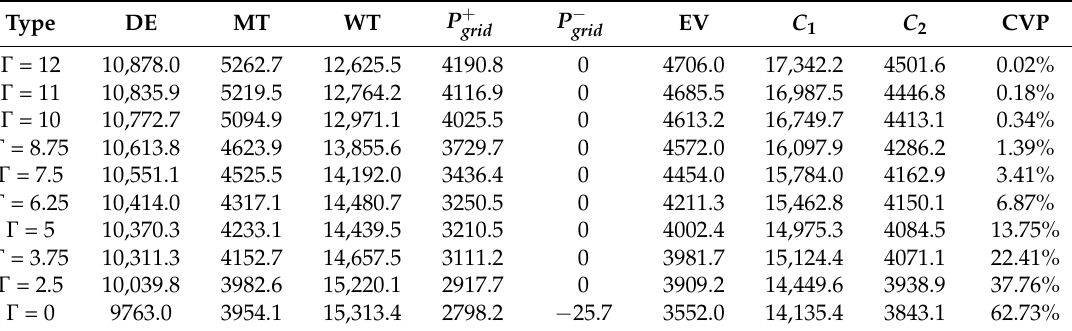
Table 4. Multi-objective dispatch robust optimization (RO) result under the adjustable robust optimization (ARO) parameter Γ